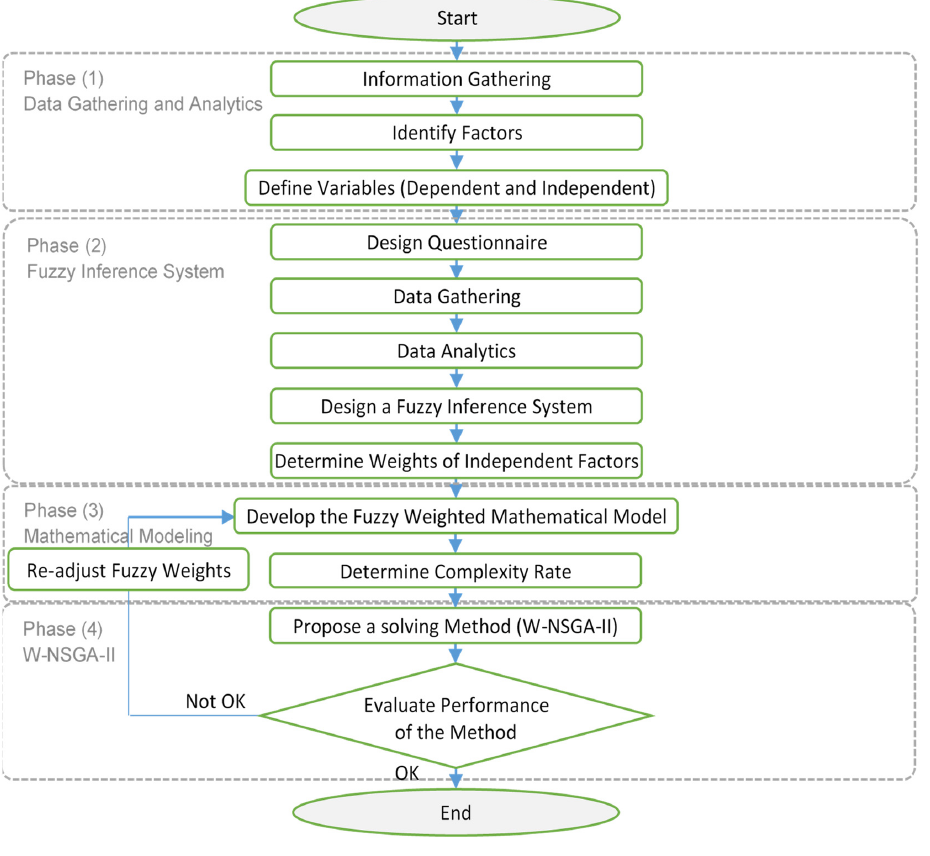
Figure 1. Flow chart of the proposed 4-phased framework.